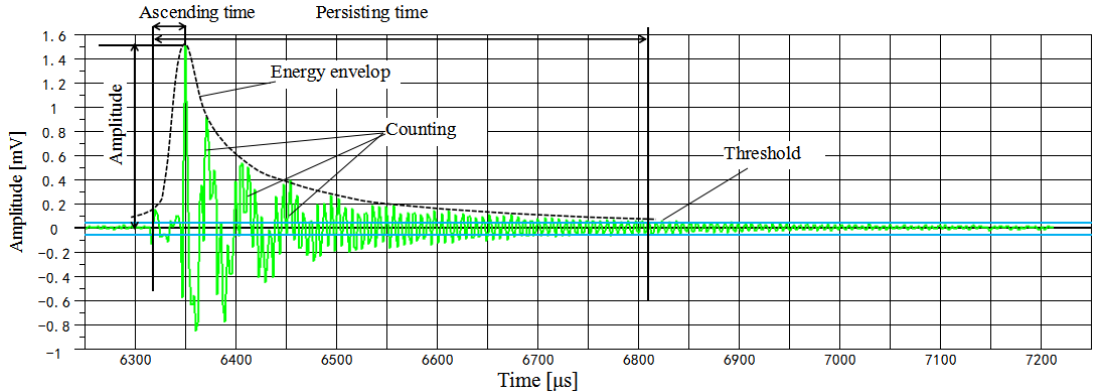
( c ) Figure 7. Engineering stress–strain curves and AE ring down count relationships at various com- pression rates: ( a ) 2 mm/min; ( b ) 10 mm/min; ( c ) 50 mm/min. 3.4. AE Energy Count and Energy Absorption E ffi ciency AE energy count [16,48,49] is considered to be proportional to the square of the am- plitude value of the waveform in which the AE event is detected, which re fl ects the inten- sity of the AE event and is related to the strain rate or microscopic deformation mechanism of the material. Figure 8 depicts the relationship between the engineering stress–strain curves and AE energy counts of open-cell aluminum foam during quasi-static compression tests. The results demonstrated that the energy counts in the elastic stage were generally high and the values fl uctuated widely. This was a tt ributed to the small deformation of the weak pore wall and prism in the structure, which resulted in the change in the cell shape (2% strain, see Figure 5). With the increase in strain, the energy count fl uctuated less, and a number of high-energy burst-type AE signals were generated between the strain of 5–20%, indicating that the structure was fractured due to deformation of the specimen, with stress concentrations occurring in the weak areas of the prisms and pore walls (5% and 16% strain, see Figure 5). In the slip zone with a 45° angle to the compression direction of the specimen, the collapse deformation of the cell pores was obvious. Then, the specimen be- gan to enter the densi fi cation stage. As the compression rate increased, the value of the energy count decreased, and the high energy burst-type signal also diminished, indicating that the deformation of the pore wall di ff ered at di ff erent compression rates or there were 0